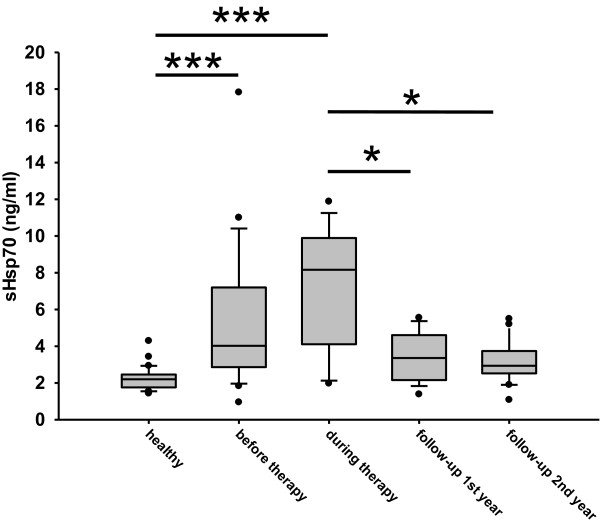
sHsp70 levels in the serum of SCCHN patients untreated and after therapy. Blood was collected from patients with SCCHN. sHsp70 concentration was measured with ELISA in three independent experiments in duplicates. Standard box plots are shown with boundaries indicating the 25th and the 75th percentile. The line inside boxes indicates the median and the whiskers indicate the 10th and 90th percentile, respectively. All outliers are shown in the graph. (healthy n = 28, before therapy n = 21, during therapy n = 10, follow-up 1st year n = 9, follow-up 2nd year n = 14). The reason for the different n numbers is due to some missing blood samples during the course of disease. (*p < 0.05, ***p < 0.001).